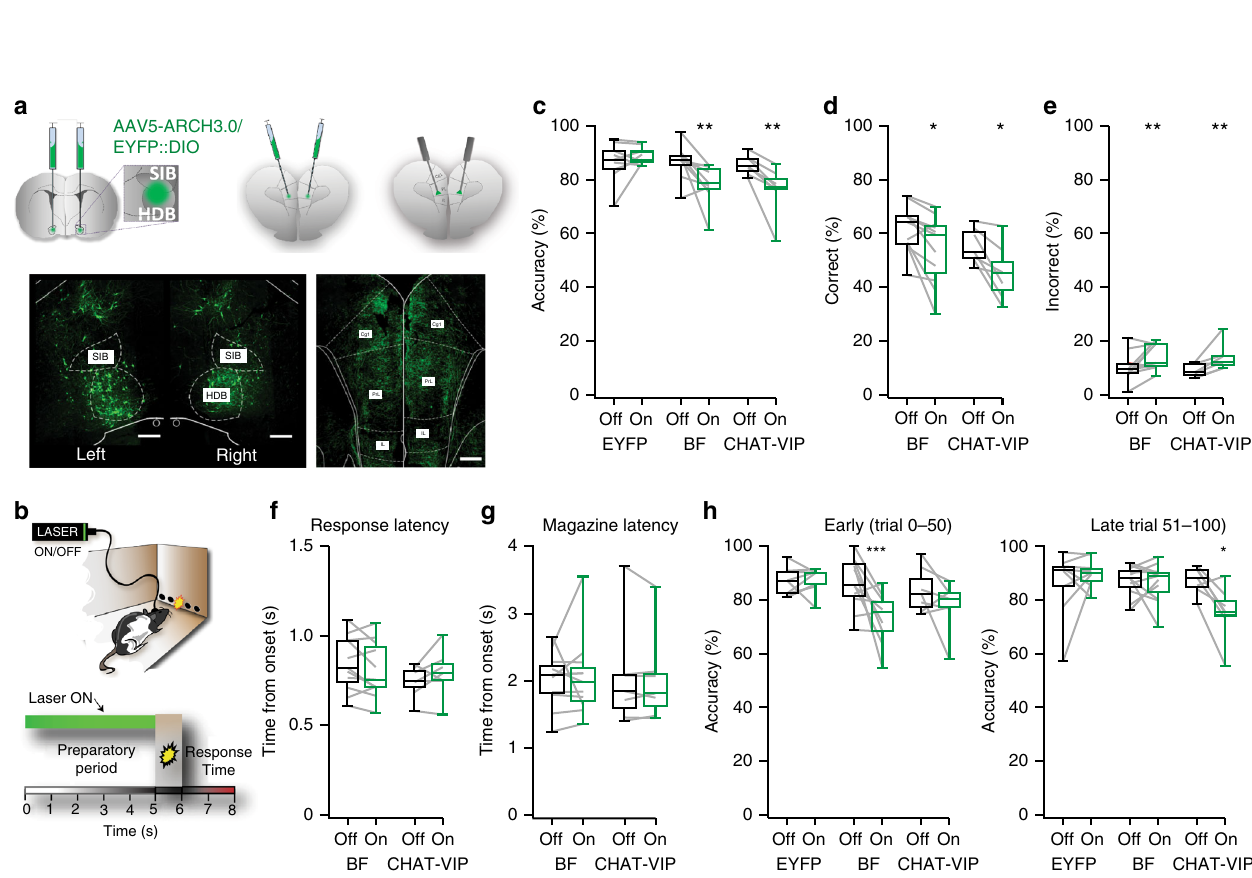
Fig. 6 ChAT-VIP neurons control attention. a Locations of virus injections, in BF (left) or mPFC (middle). Optic fi bres were implanted over the PrL mPFC (right). Below: EYFP expression in BF neurons (left image) and EYFP-positive fi bres in mPFC (right image). Scale bars 500 μ m. b Cartoon and schematic representation of a trial. Green bar indicates the period of optogenetic inhibition. Laser-ON and laser-OFF trials were assigned randomly in each session (50 ON, 50 OFF). c Accuracy of responding by rats injected either in BF or mPFC (CHAT-VIP), or control littermates that received only AAV5::DIO-EYFP injections [CTRL: n = 9; ChAT-VIP: n = 7; BF: n = 11; two-way ANOVA, effect of interaction light × virus F (2,24) = 5.920; p = 0.0081; Sidak ’ s correction ChAT-VIP: p = 0.0102 ON vs. OFF; Sidak ’ s correction BF: p = 0.0030 ON vs. OFF]. Green boxes represent laser-ON trials, black boxes represent laser-OFF trials. Box plot centre line: median; bounds of box: 25th to 75th percentile; whiskers: min-max data bound. d Percent of correct responses (two-way ANOVA; effect of interaction light × virus F (2,24) = 4.088; p = 0.0297; Sidak ’ s correction ChAT-VIP: p = 0.0214, BF: p = 0.0288 ON vs. OFF). e Percent of incorrect responses (two-way ANOVA; effect of interaction light × virus F (2,24) = 3.835; p = 0.0359; Sidak ’ s correction ChAT-VIP: p = 0.0314, BF: p = 0.0254 ON vs. OFF). f Time to respond to light cues (latency correct latency ChAT-VIP: t = 1.389; p = 0.2141; BF: t = 1.576; p = 0.142. Incorrect latency ChAT-VIP: t = 1.173; p = 0.2851; BF: Wilcoxon matched-pairs signed rank test; p = 0.6523, ON vs. OFF). Grey shaded area represents the duration of the stimulus light presentation. g Time to collect reward at the magazine. Wilcoxon matched-pairs signed rank test; ChAT-VIP: p = 0.9063; BF: p = 0.4785). Grey shaded area represents the duration of the stimulus light presentation. h Accuracy of responding during early trials and late trials [BF projections inhibition in mPFC: two-way ANOVA effect of interaction light × virus: F (2,24) = 3.744; p = 0.0385; Sidak ’ s correction BF: p = 0.0022 ON vs. OFF], [ChAT- VIP cell inhibition in mPFC: two-way ANOVA effect of interaction light × virus F (2,24) = 3.744; p = 0.0161 Sidak ’ s correction ChAT-VIP: p = 0.0125 ON vs. OFF]. Green bars represent trials with laser-ON. Black bars represent laser-OFF trials. Values are expressed in percent as mean ± SEM. Asterisks: 1 = p < 0.05, 2 = p < 0.01, 3 = p <